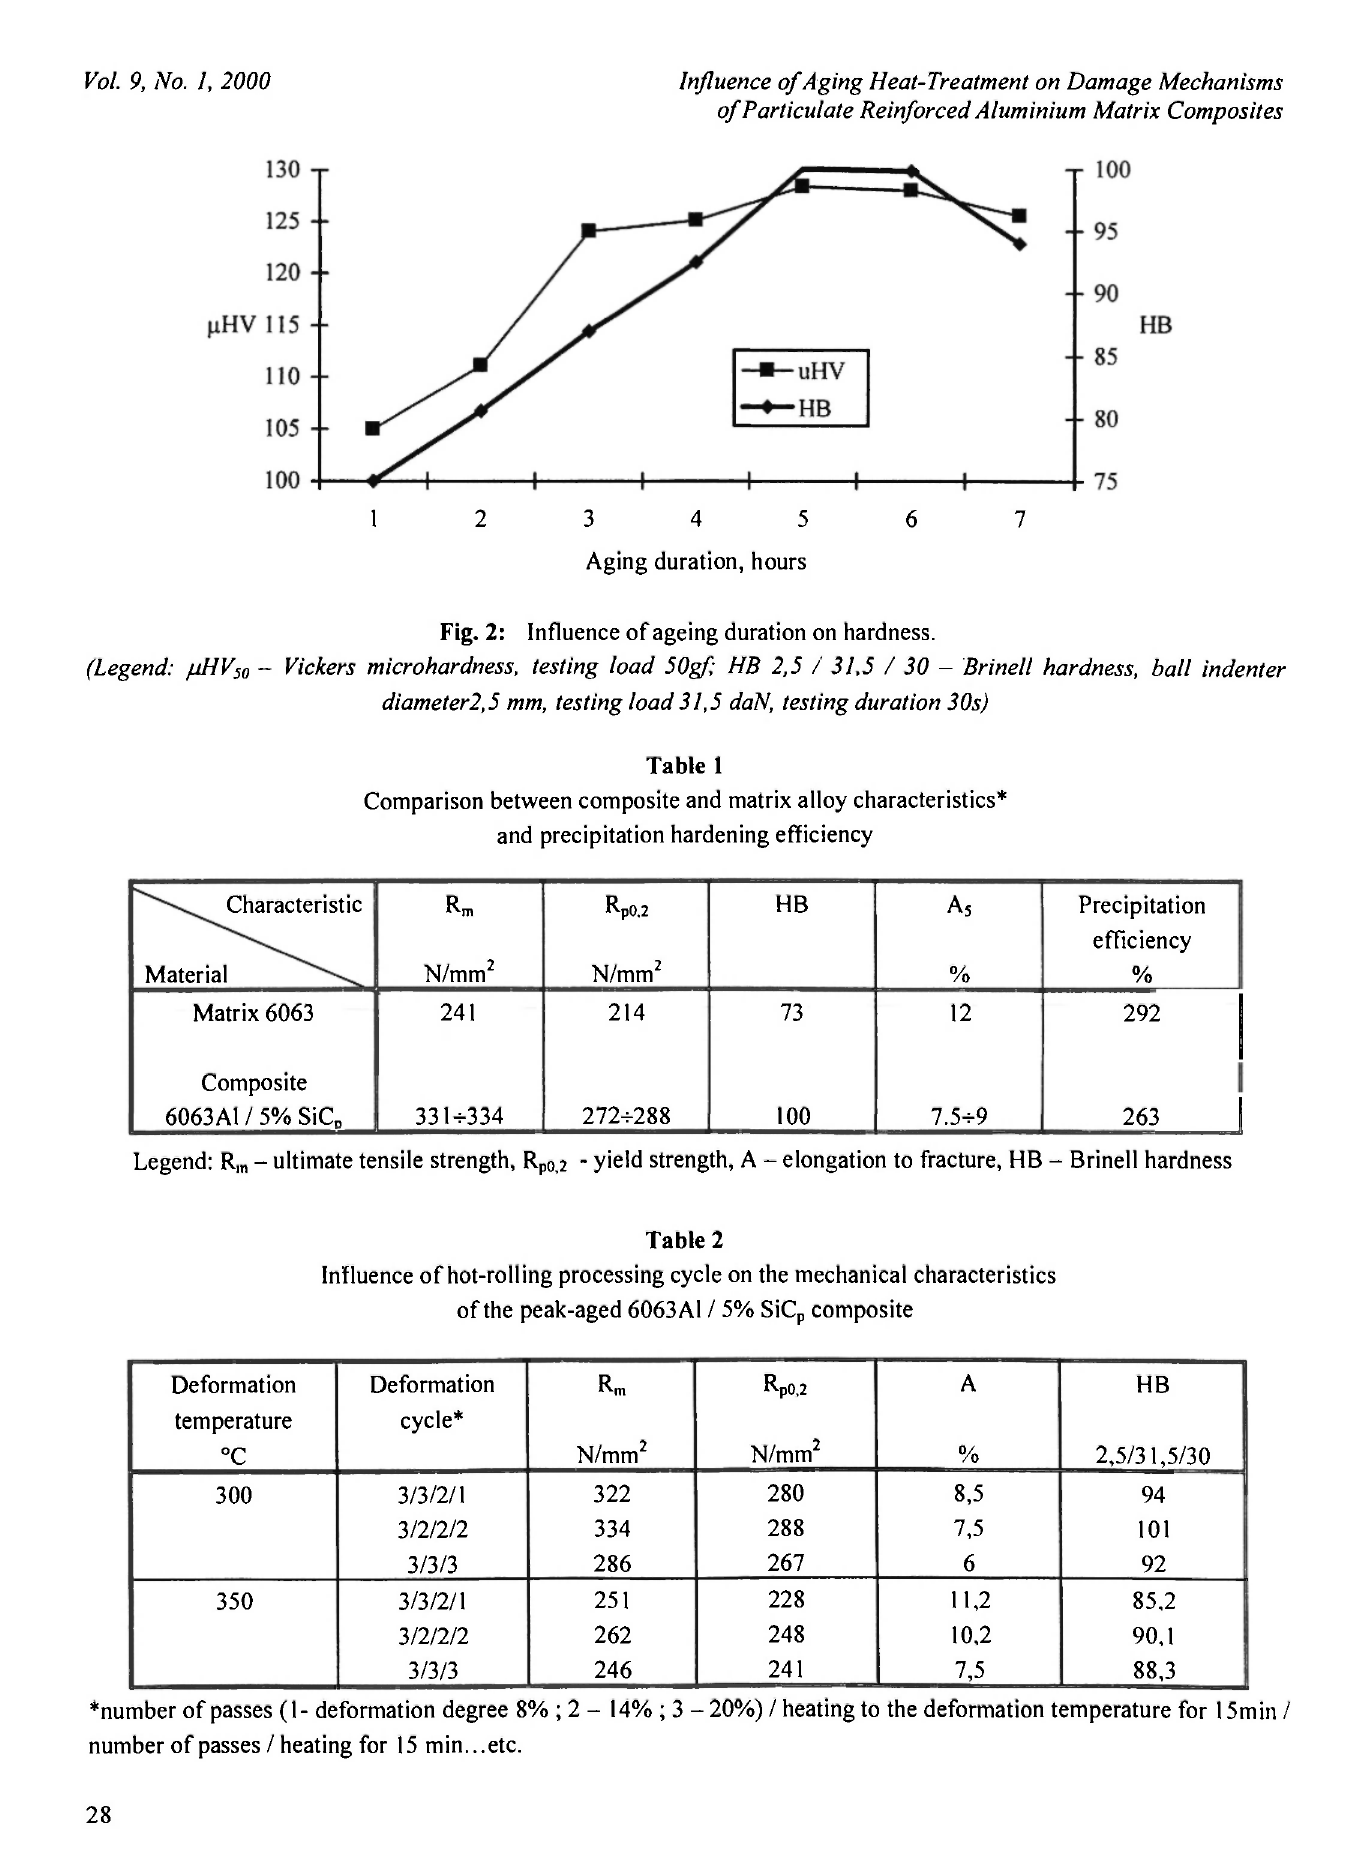
Influence of hot-rolling processing cycle on the mechanical characteristics of the peak-aged 6063 Al / 5% SiC p